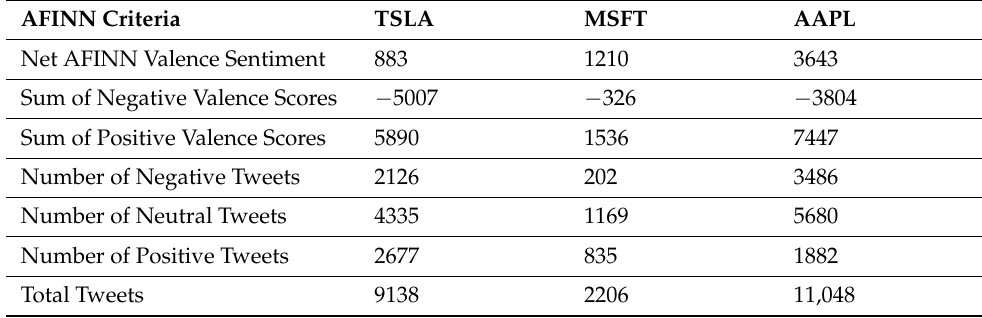
Table 4. Initial Data Exploration of AFINN